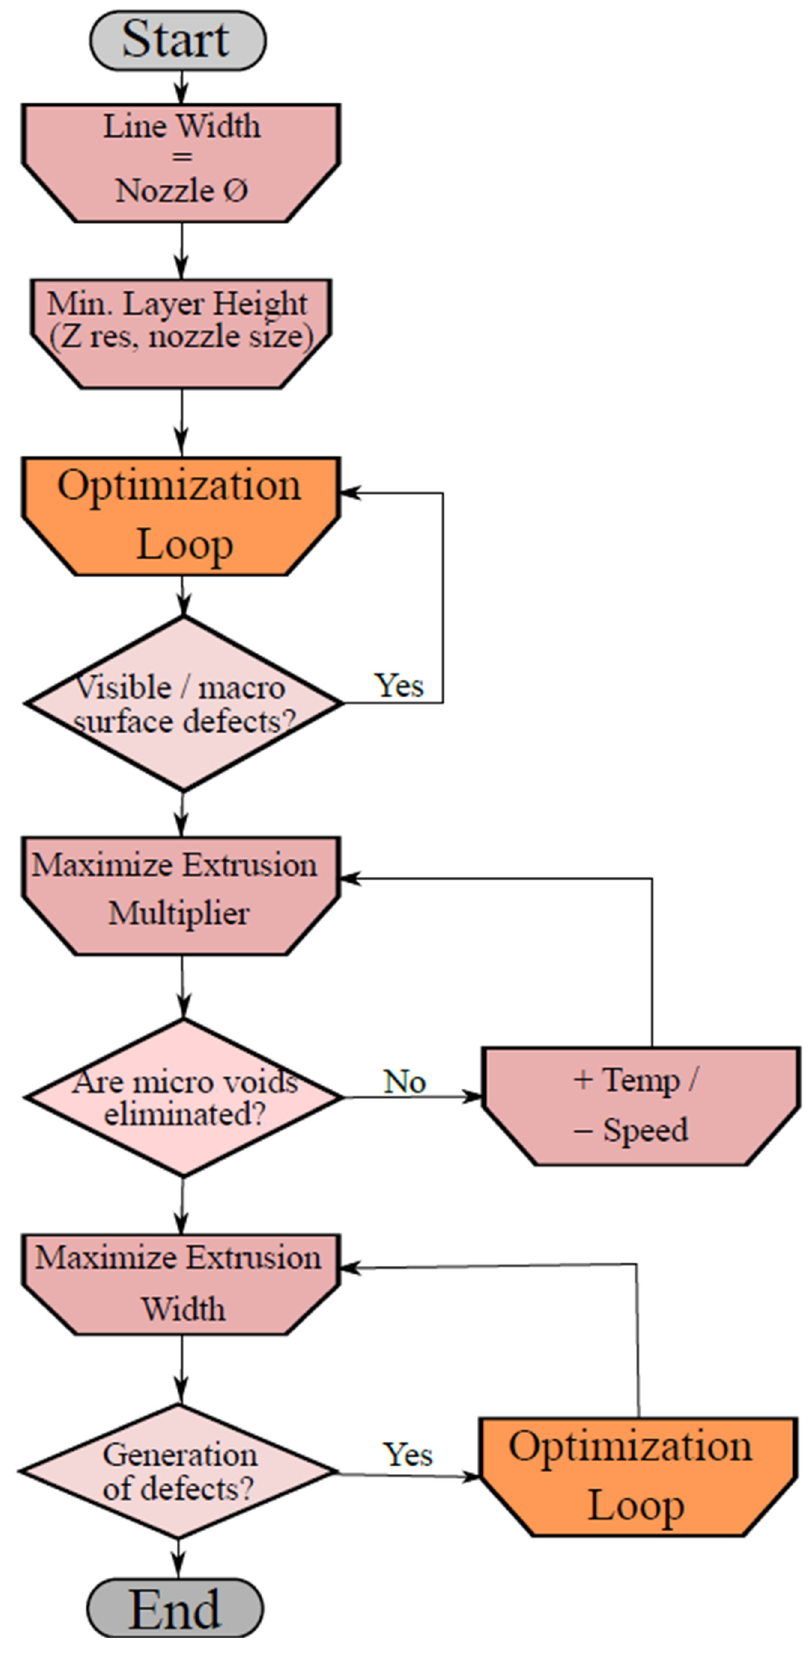
Figure 14. Flow chart of the optimization process.